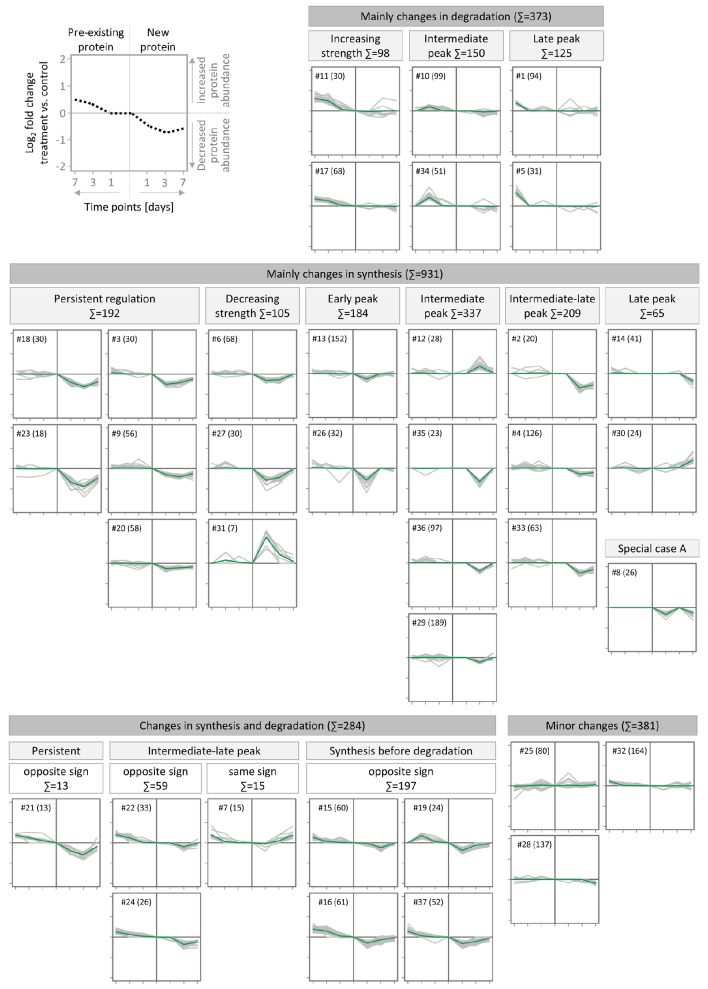
Clusters of temporal protein profiles observed during BIC-induced down-scaling.Proteins were clustered using their temporal profiles of pre-existing and newly synthesized proteins by kmeans clustering. For each cluster, the temporal profiles of all members are shown in gray and the average profile is shown in green. The cluster number (#) and number of protein members (in brackets) are indicated. Clusters with similar profiles were manually assigned to upper-level groups. The schematic in the top left panel provides the axis information for the displayed clusters. The dashed line represents the temporal profile of an exemplary protein.